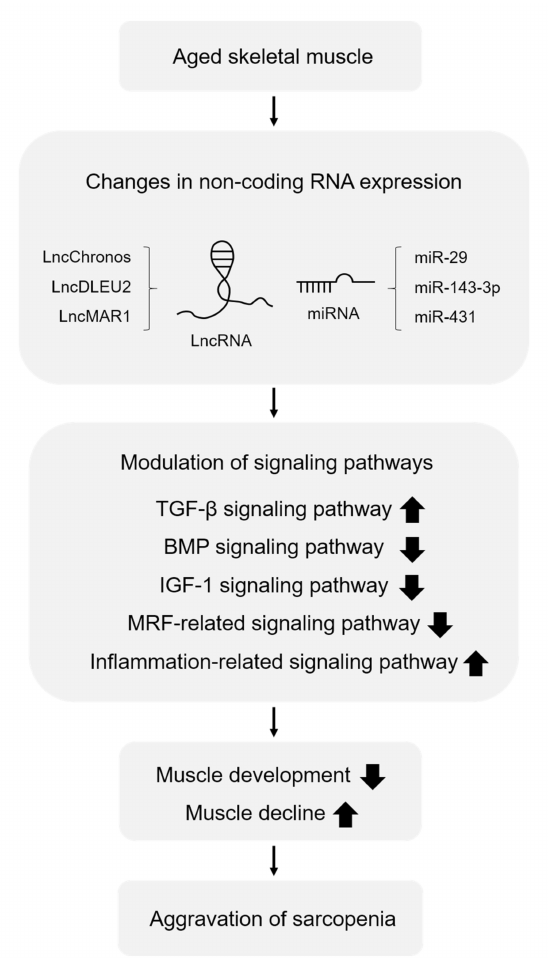
Figure 1. Alteration in non-coding RNA levels regulates multiple signaling pathways in aged skeletal muscle. Sarcopenia is caused by activation of the TGF- β signaling pathway, as well as inactivation of the BMP signaling pathway, IGF-1 signaling pathway, and MRF-related signaling pathway. Non- coding RNAs are involved in these signaling pathways by regulating gene networks and modulating the pathogenesis of